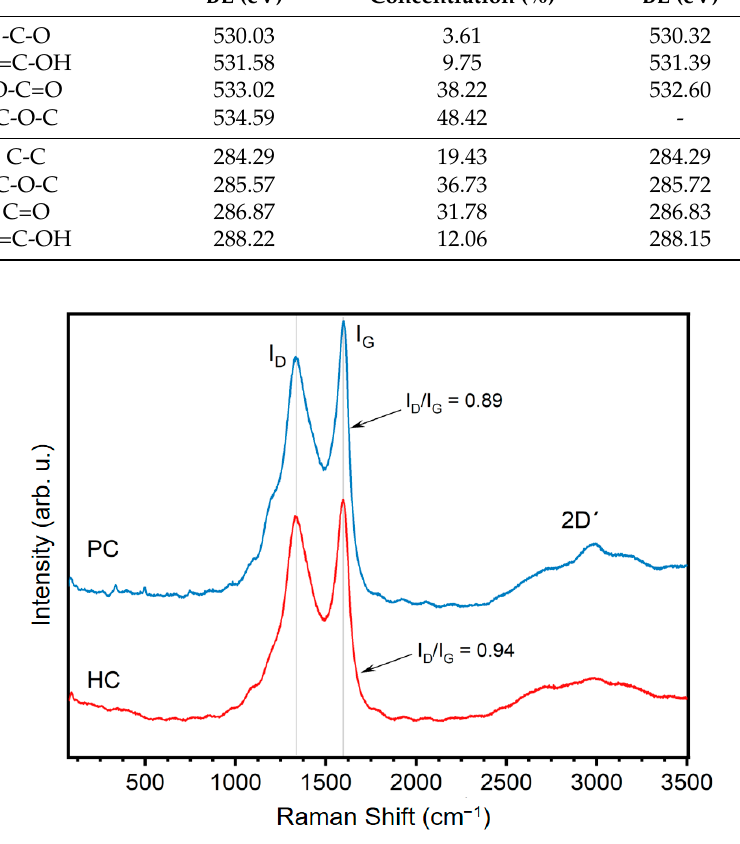
Figure 5. Raman spectra of HC and PC biochar showing its primary features.